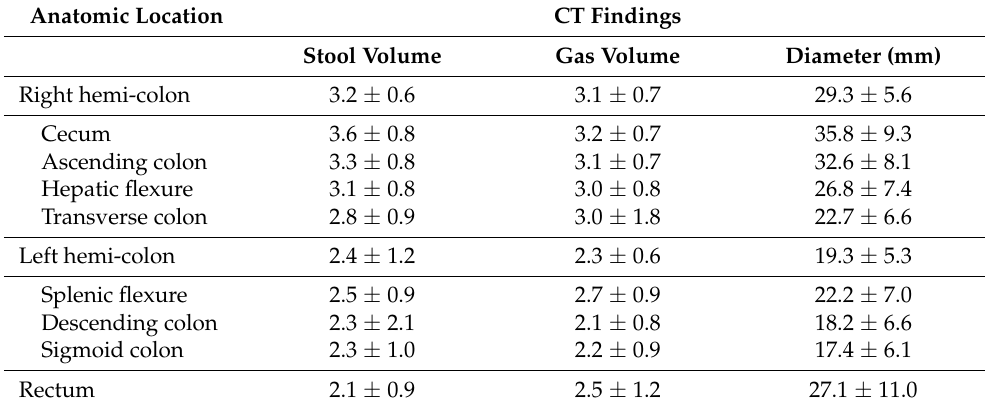
Table 2. Evaluation of CT images and